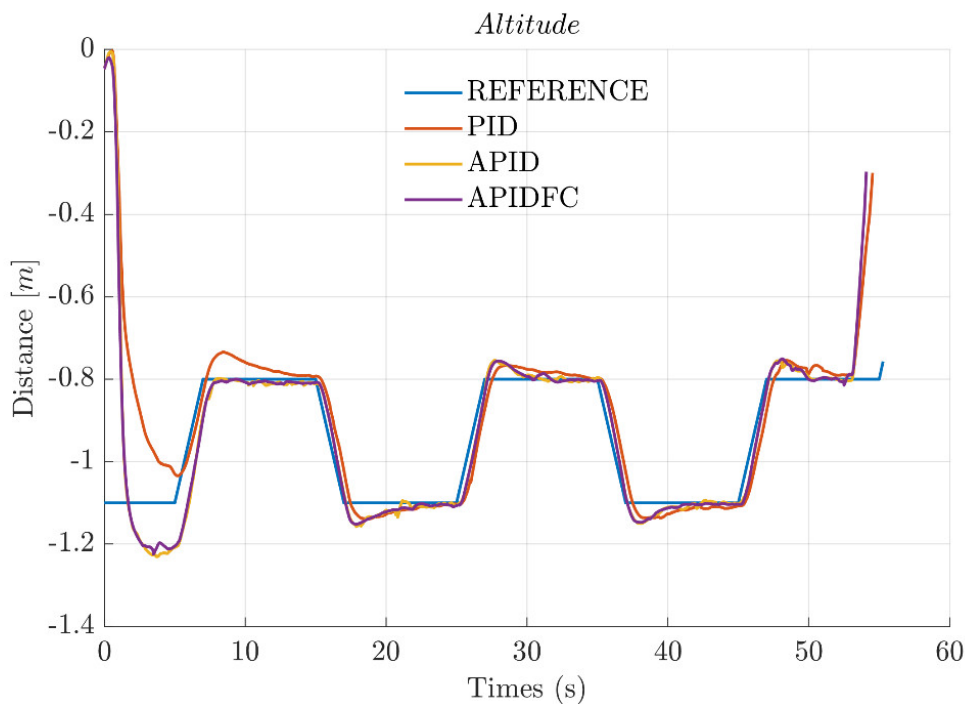
Figure 18. Altitude response to following the trapezium wave reference.